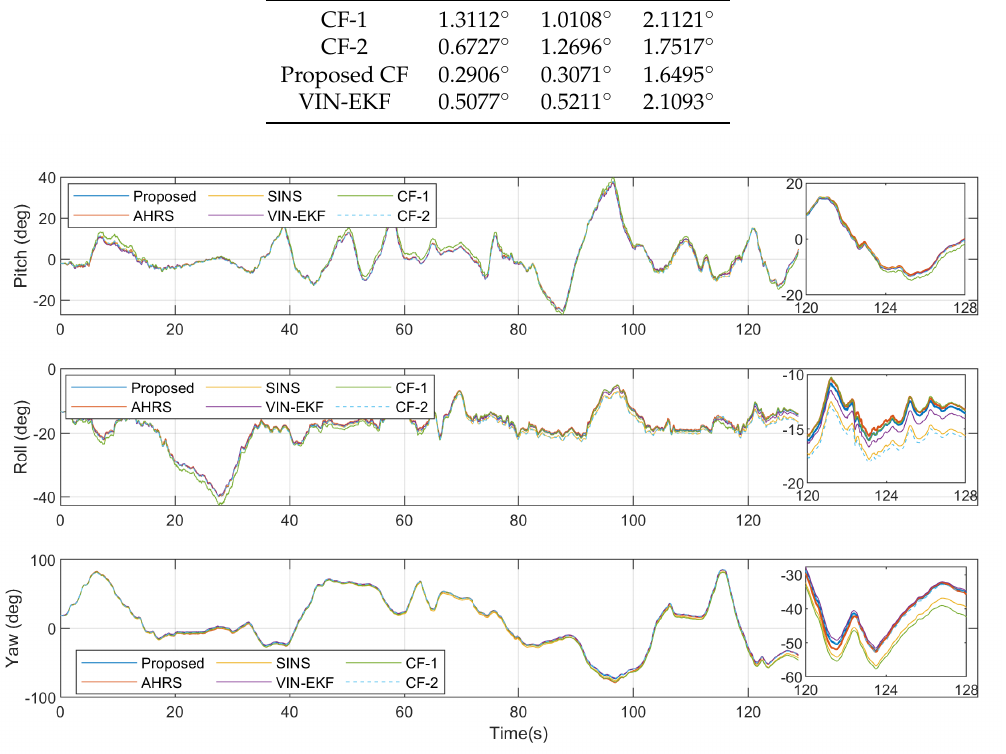
Figure 6. Attitude estimation results in the dynamic case.